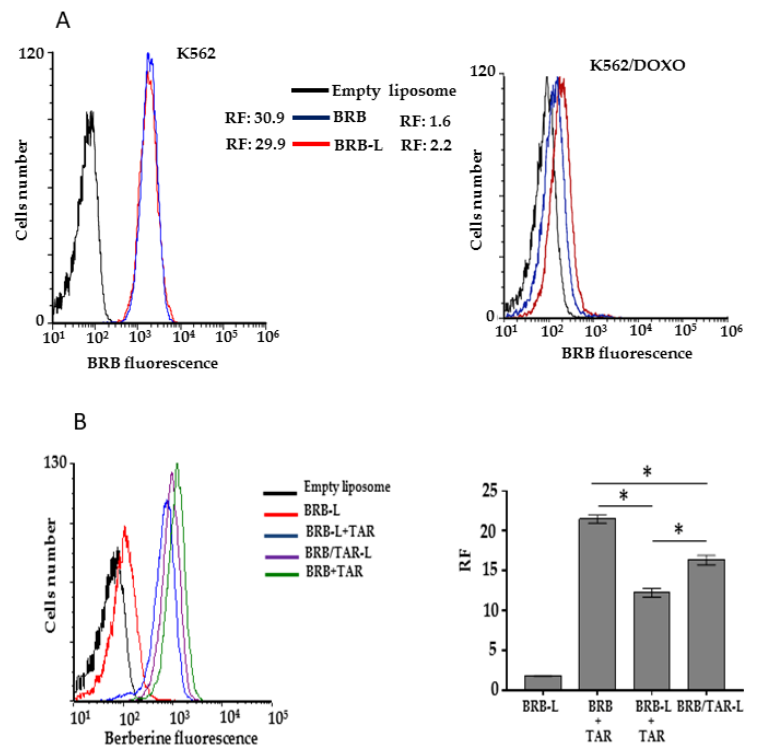
Figure 9. ( A ) uptake of BRB or BRB-L by K562 and K562/DOXO cells, after 2 h-incubation; ( B ) uptake of BRB/TAR, BRB-L/TAR, or BRB/TAR-L by K562/DOXO cells, after 2 h-incubation. RF = fluorescence ratios of sample treated and the control (empty liposome), * p < 0.05.